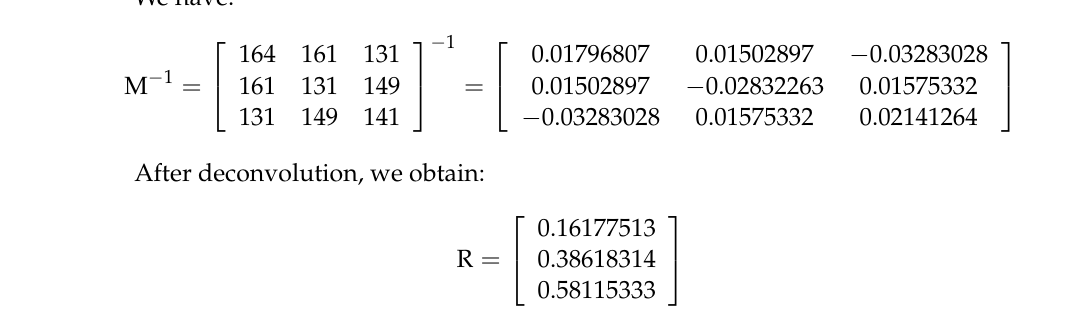
No treatment Antiviral therapy